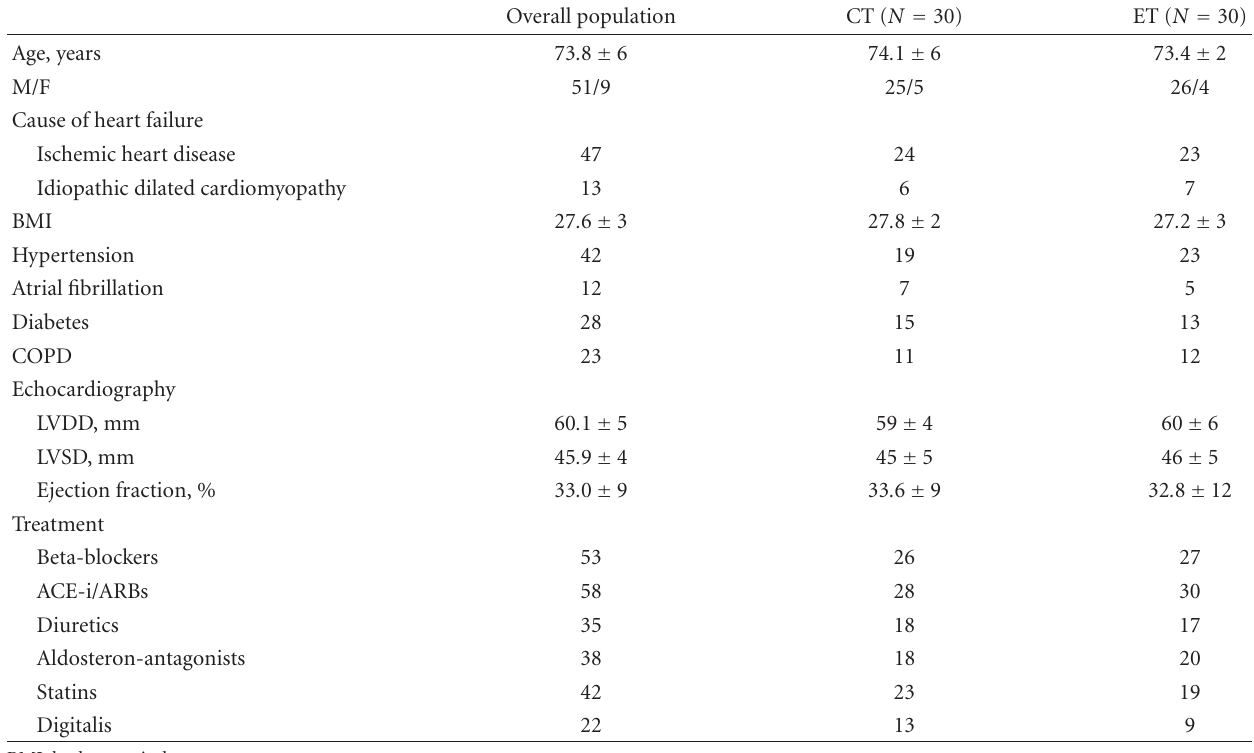
BMI: body mass index LVDD: left ventricular diastolic diameter LVDD: left ventricular systolic